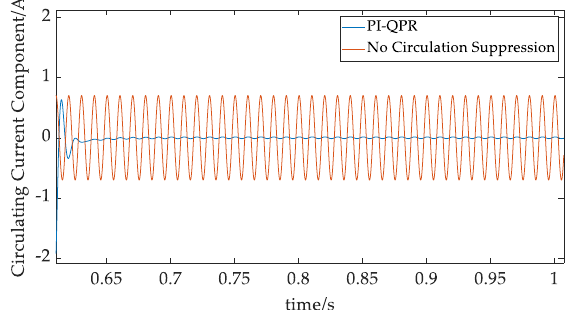
Figure 9. Circulating current suppressing effect under PI-QPR.